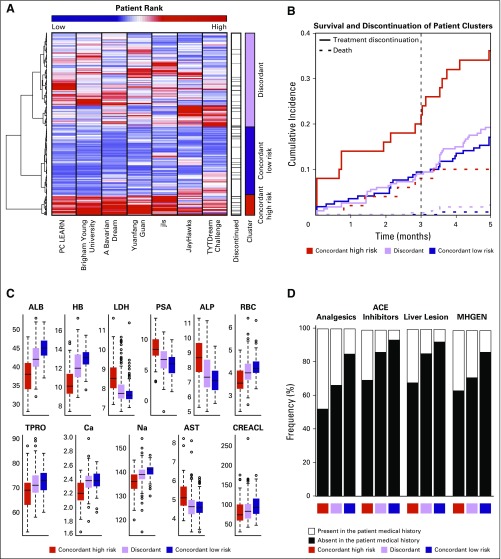
Meta-analysis of risk scores computed by the seven top-performing teams. (A) Hierarchical clustering heatmap of patients in the ENTHUSE 33 validation data set (n = 470) on the basis of their normalized ranked risk score, computed across the seven top-performing teams. (B) Kaplan-Meier curves, stratified by event type—that is, death or treatment discontinuation—across the three identified patient subgroups. (C) Distribution of baseline laboratory variables found to be significantly different between the three patient subgroups. (D) Distribution of baseline prior medical and medication variables found to be significantly different between the three patient subgroups. ACE, angiotensin-converting enzyme; ALB, albumin; ALP, alkaline phosphatase; Ca, calcium; CREACL, creatinine clearance; HB, hemoglobin; LDH, lactate dehydrogenase; MHGEN, medical history: general disorders and administration site conditions; Na, sodium; PSA, prostate-specific antigen; TPRO, total protein.